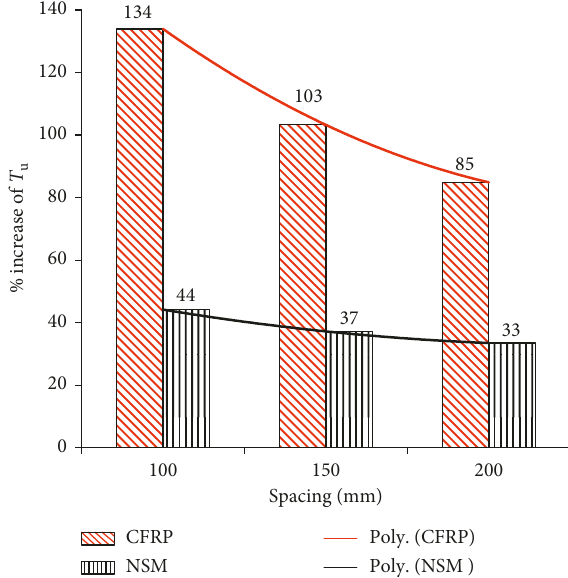
Figure 13: Influence of CFRP and NSM steel bar spacing on the torsional strength.